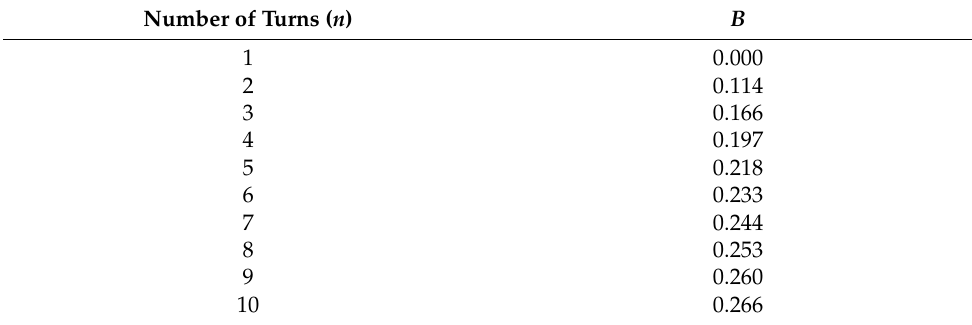
Table 2. Correction values of constant B in Equation (3) from 1 to